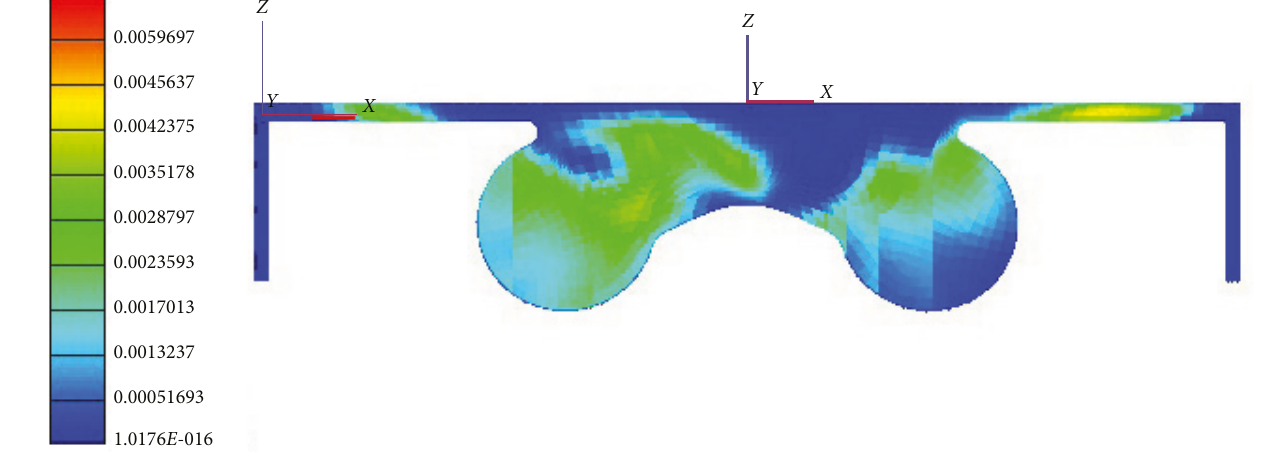
Figure 8: The distribution of NO